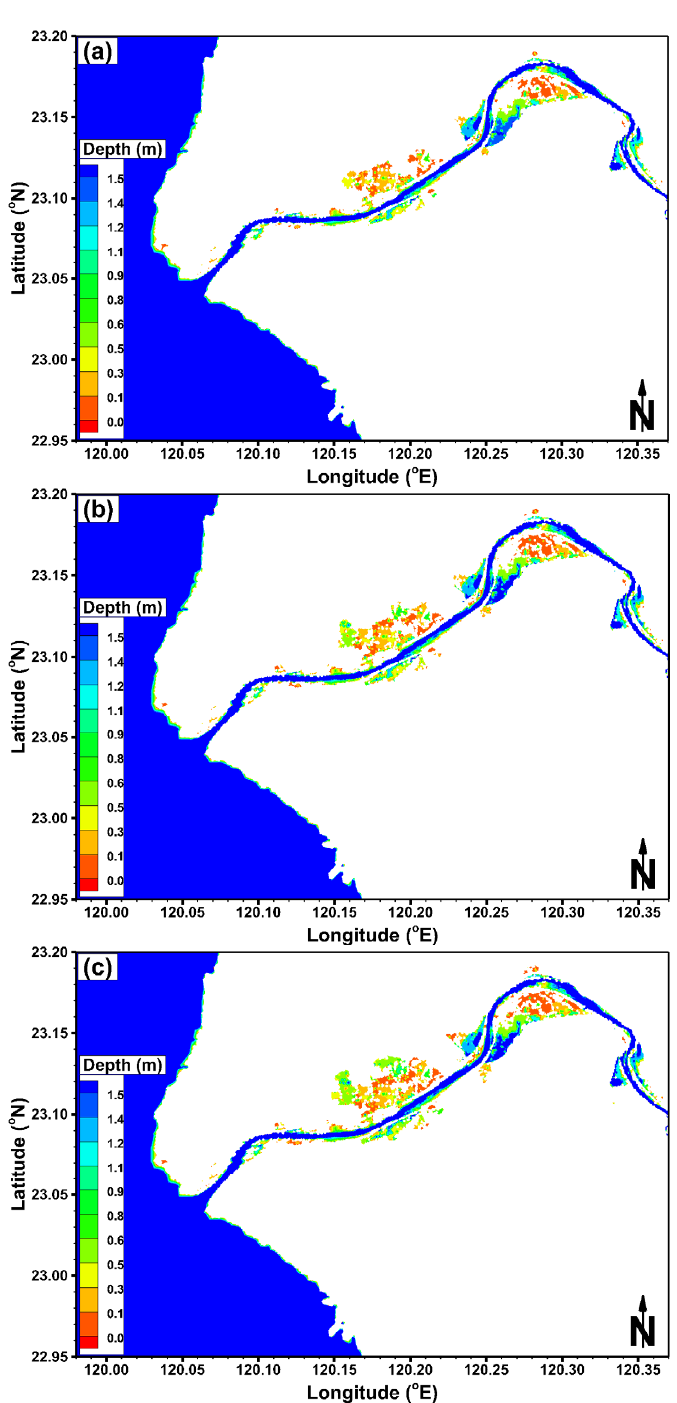
Figure 10. Inundation extent and depth induced by a freshwater discharge only during peak